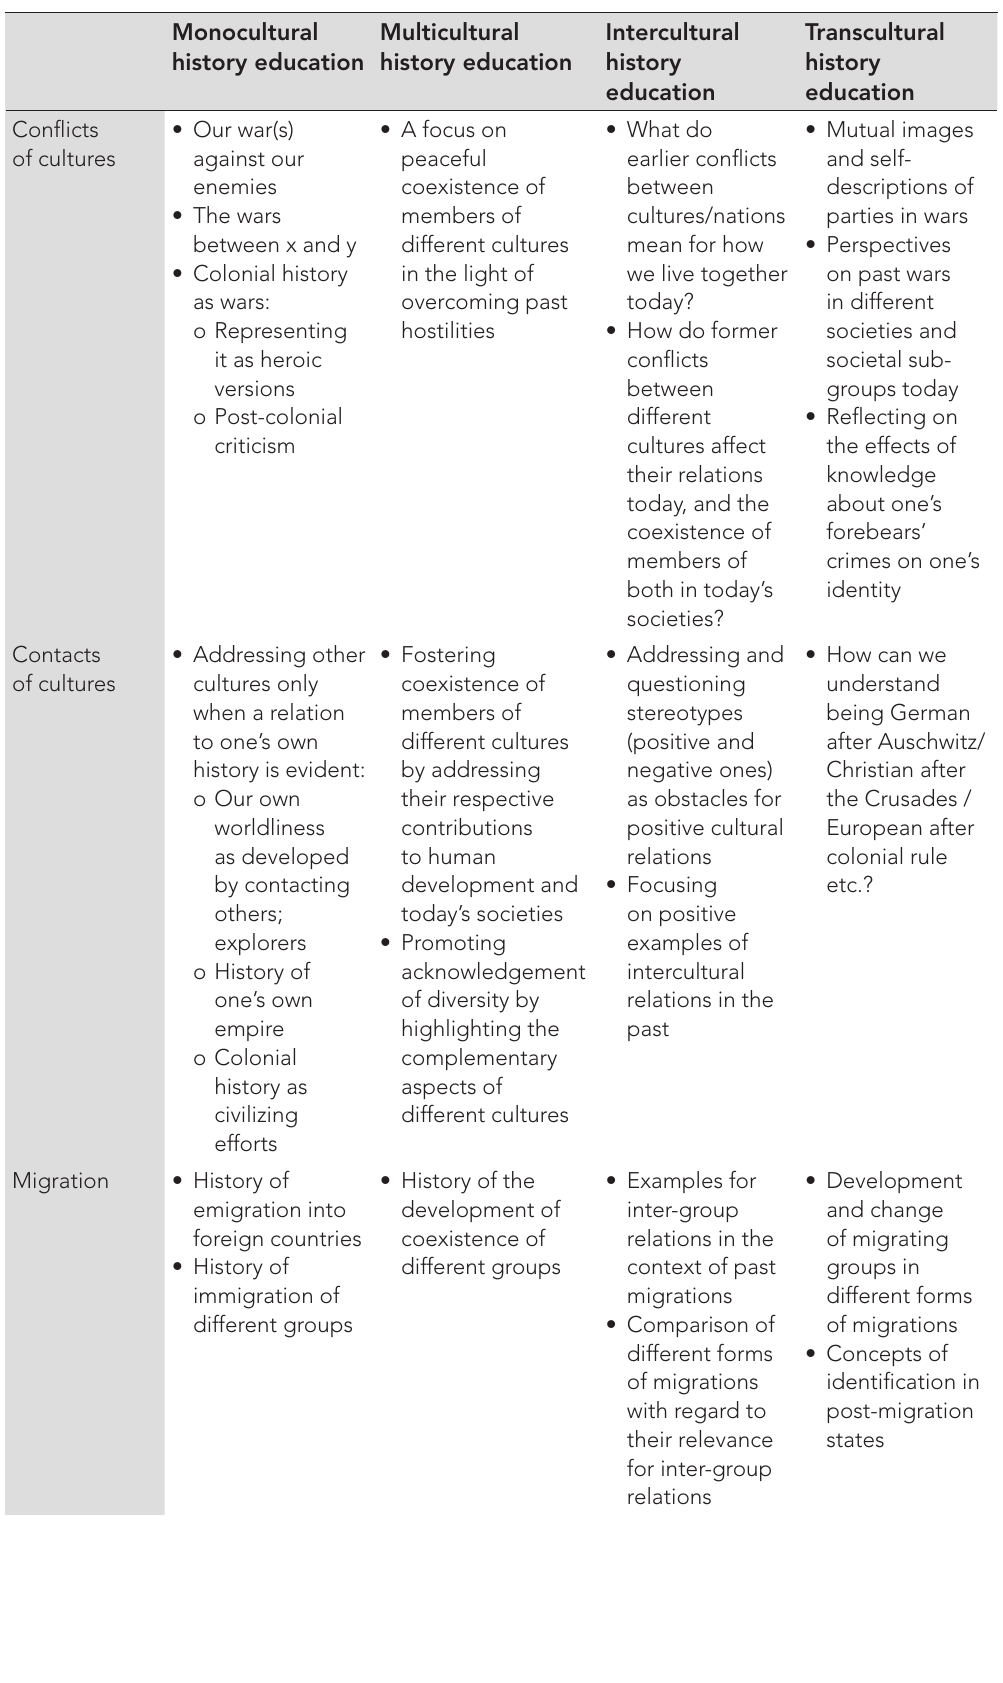
Table 3: Consequences of cultural learning concepts for addressing subjects